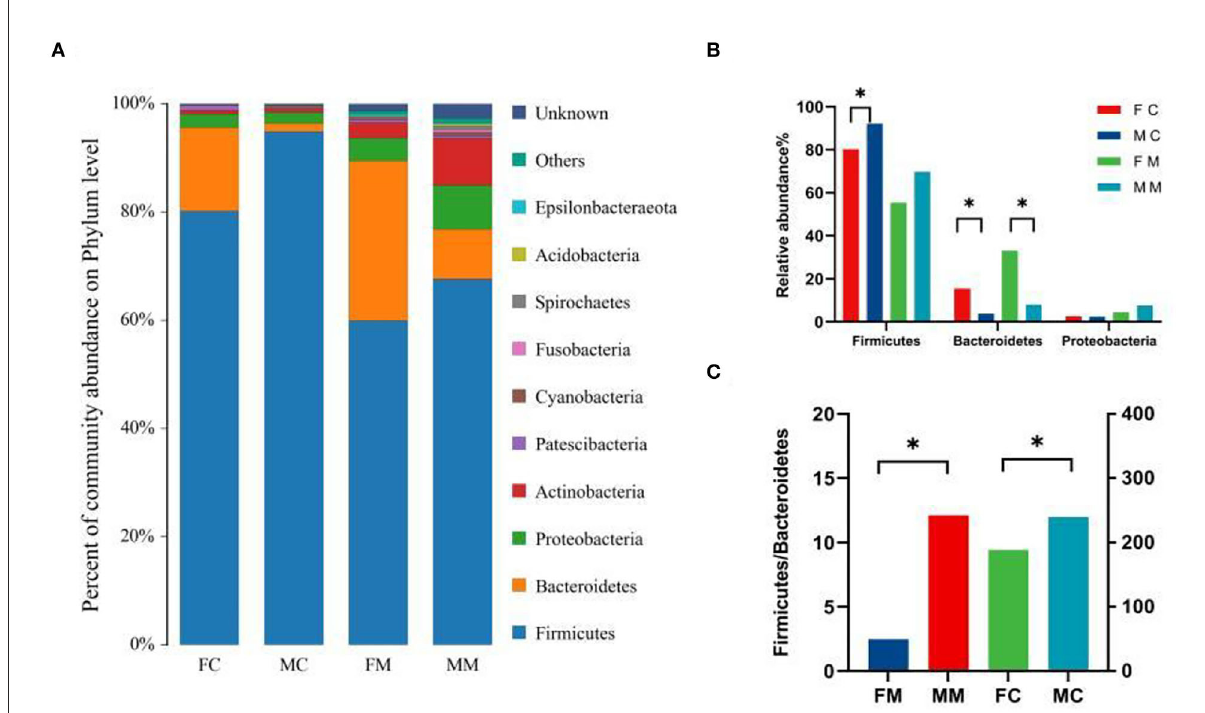
FIGURE5 (A) The bacterial species and relative abundance of each group at the genus level, (B) illustration of sex differences in the relative abundance of the top 30 major genera (* p < 0.05, ** p < 0.01, *** p < 0.01).